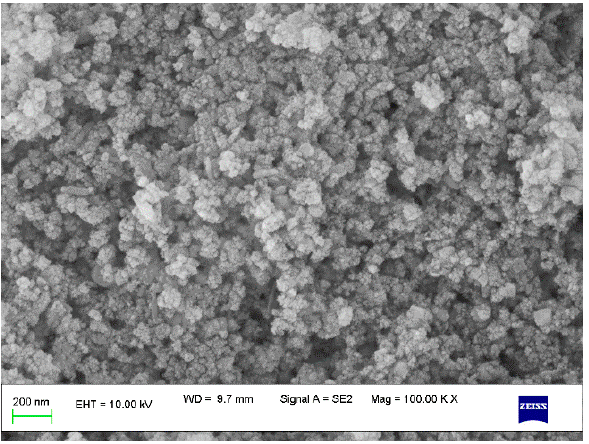
Figure 4. SEM images of ZnONPs synthesized using Withania somenifera root extract.